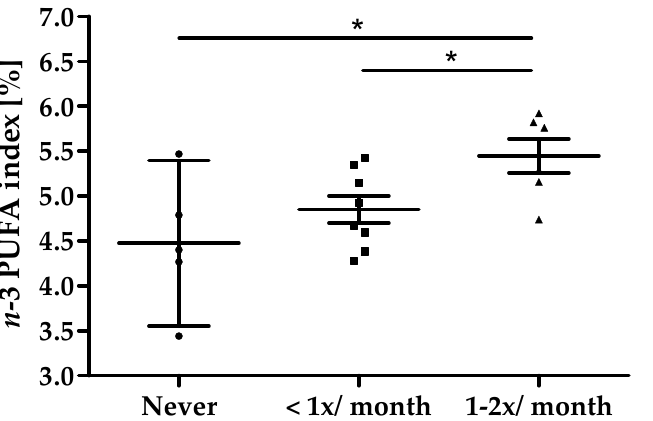
Table 3. EPA and DHA in fasting plasma samples ( n = 19).